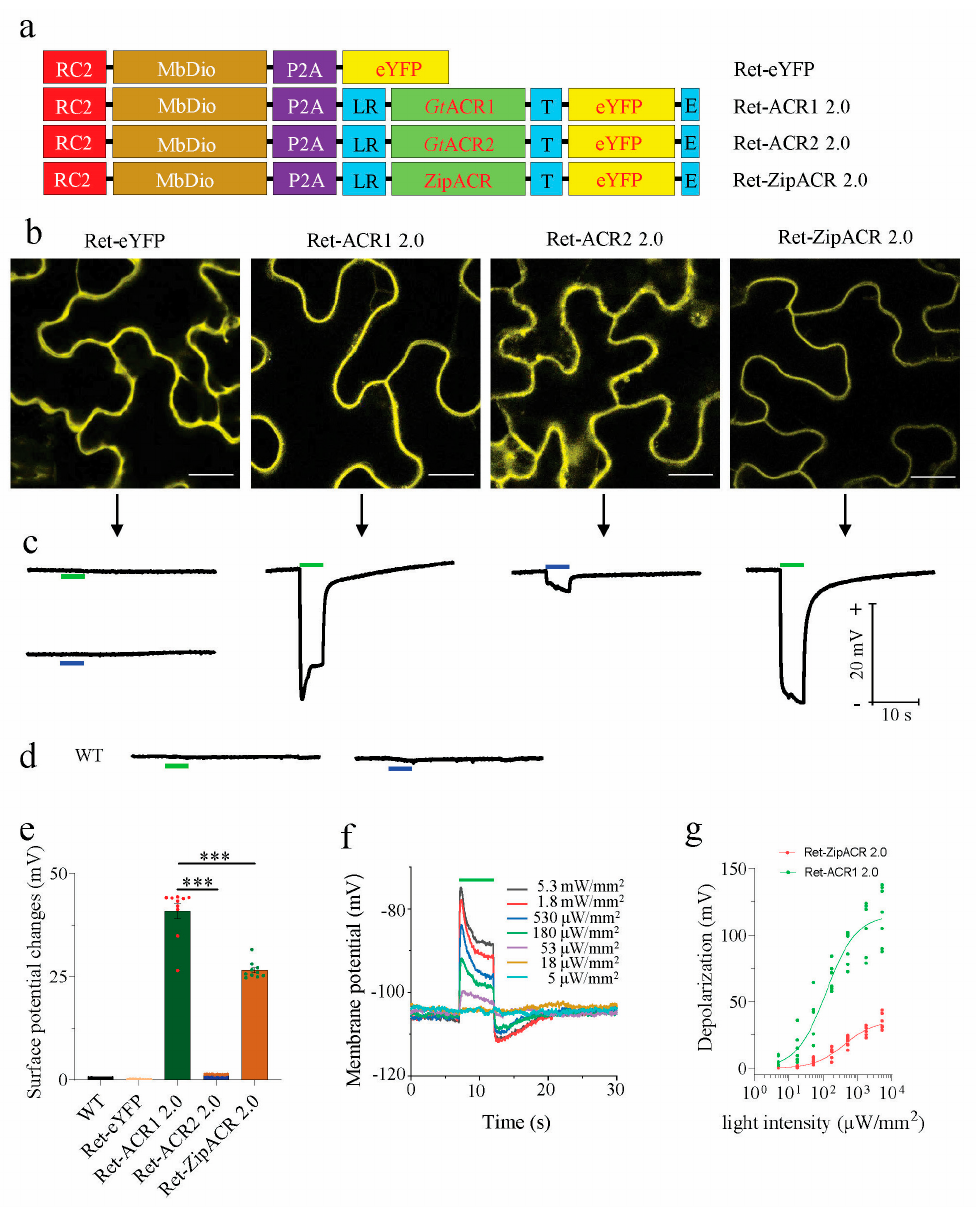
Figure 2. Functional expression of ACR2 and ZipACR in N. benthamiana leaves. ( a ) Schemes of the Ret-eYFP, Ret-ACR1 2.0, Ret-ACR2 2.0 and Ret-ZipACR 2.0 DNA constructs. ( b ) Representative confocal images of N benthamiana epidermal cells expressing Ret-eYFP (n =15), Ret-ACR1 2.0 (n = 15), Ret-ACR2 2.0 (n = 11) and Ret-ZipACR 2.0 (n = 3), the images were taken 3 days post infiltration (dpi), scale bar = 200 µm. ( c ) Surface potential recordings on N. benthamiana leaves expressing Ret-eYFP, Ret-ACR1 2.0, Ret-ACR2 2.0 and Ret-ZipACR 2.0 upon 532 nm green light (green bar) or 473 nm blue light (blue bar) with 180 µW/mm 2 for 5 s, n = 10 for each construct, and the recording was performed 3 dpi. ( d ) The surface potential recordings on the leaves of wild-type N. benthamiana (WT) with 180 µW/mm 2 532 nm green light (green bar) and 473 nm blue light (blue bar) for 5 s, n = 10. ( e ) The comparison of light-induced surface potential changes on N. benthamiana leaves expressing Ret-eYFP, Ret-ACR1 2.0, Ret-ACR2 2.0, and Ret-ZipACR 2.0 illuminated with the same wavelength as in ( d ), WT and Ret-eYFP-expressing plants were exposed to green light (532 nm). The statistical significance is performed by One-way ANOVA following the Turkey test. Ret-ACR 1 2.0 vs. Ret-ACR 2 2.0, p = 6.8 × 10 − 13 , Ret-ACR1 2.0 vs. Ret-ZipACR 2.0, p = 7.2 × 10 − 13 . ( f ) A representative membrane potential recording in mesophyll cells of N. benthamiana leaves expressing Ret-ZipACR 2.0 under 5 s green light (532 nm, green bar) of different intensities. ( g ) The comparison of the light sensitivity of Ret-ACR1 2.0 and Ret-ZipACR 2.0, for Ret-ACR1, EPD 50 = ~125 µ W/mm 2 , and for Ret-ZipACR 2.0, EPD 50 = ~420 µ W/mm 2 ). ***, p ≤